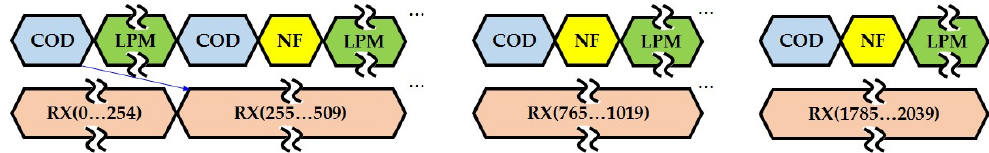
Figure 14. Timing diagram for writing NAND flash memory at 115200 baud.